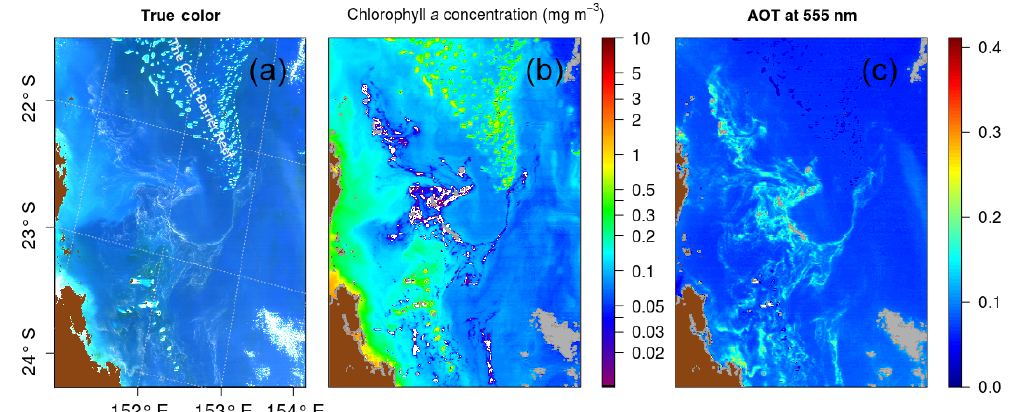
Figure 2. MODIS Aqua tile A2007290.0355 used in McKinna et al. (2011): (a) RGB (red, green, blue) image from R rc generated with R = 645, G = 555, and B = 469nm computed using the formulae 0 . 29319407 + 0 . 45585 × atan ( 50 × (R rc ) − 0 . 015 ) ; (b) aerosol optical thickness at 555nm derived using the NIR atmospheric correction algorithm by Gordon and Wang (1994); (c) chlorophyll concentration product computed from R rs using OC3 and OCI (Hu et al., 2012). Cloud pixels are in grey and land pixels are in brown.